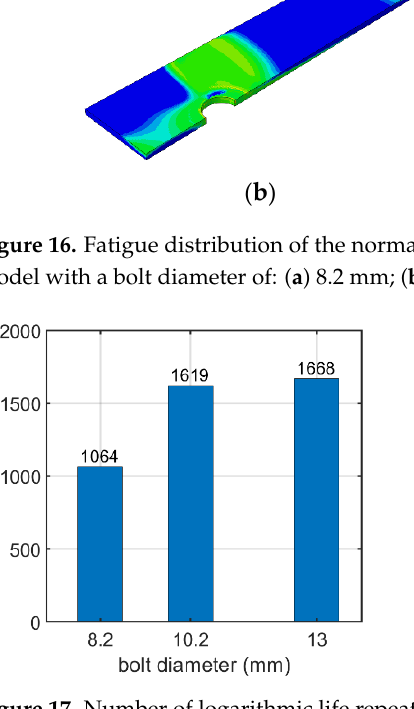
Figure 17. Number of logarithmic life repeats for diameter parameterization of the nutless bolt.